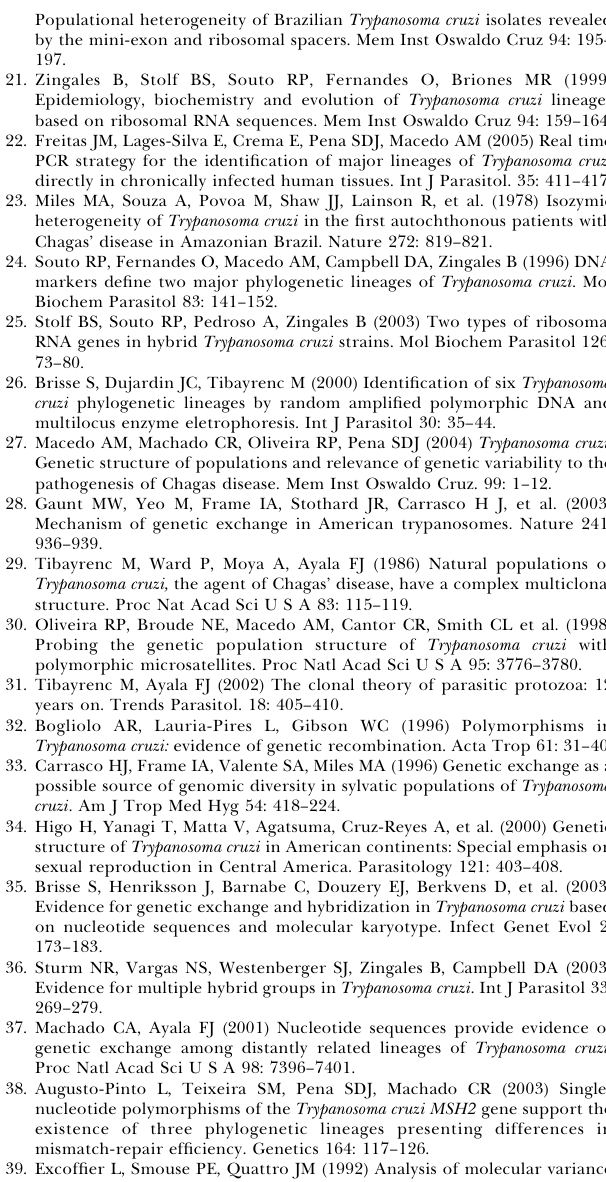
Table S1. Typing of rDNA Group and Allele Sizes (in bp) of Five Microsatellite Loci Found at DOI: 10.1371/journal.ppat.0020024.st001 (105 KB